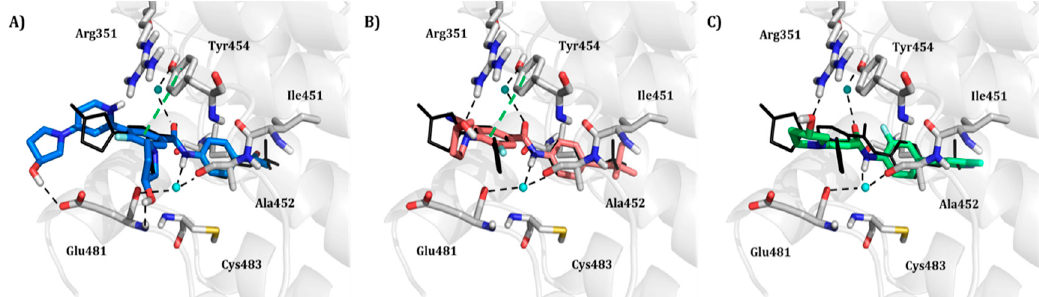
Figure 10. Molecular interactions between Bcl-Abl (PDB entry, 5MO4 [67]) and the docking top-scored de novo generated compounds taken from Bcr-Abl.lib referring to the compound Bcr-Abl.lib_01 ( A ), Bcr-Abl.lib_02 ( B ) and Bcr-Abl.lib_03 ( C ), respectively. The water bridge molecules are shown as cyan spheres. ABL001 is depicted in the black wireframe. Black and green dashed lines indicate hydrogen bonds and π - π interactions, respectively. For the sake of clarity, only polar hydrogen atoms are shown.